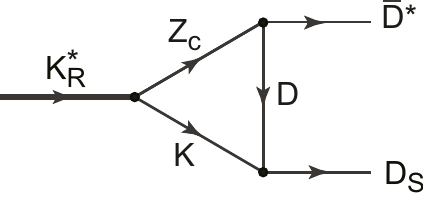
Figure 4 . Decay process of K (cid:3)